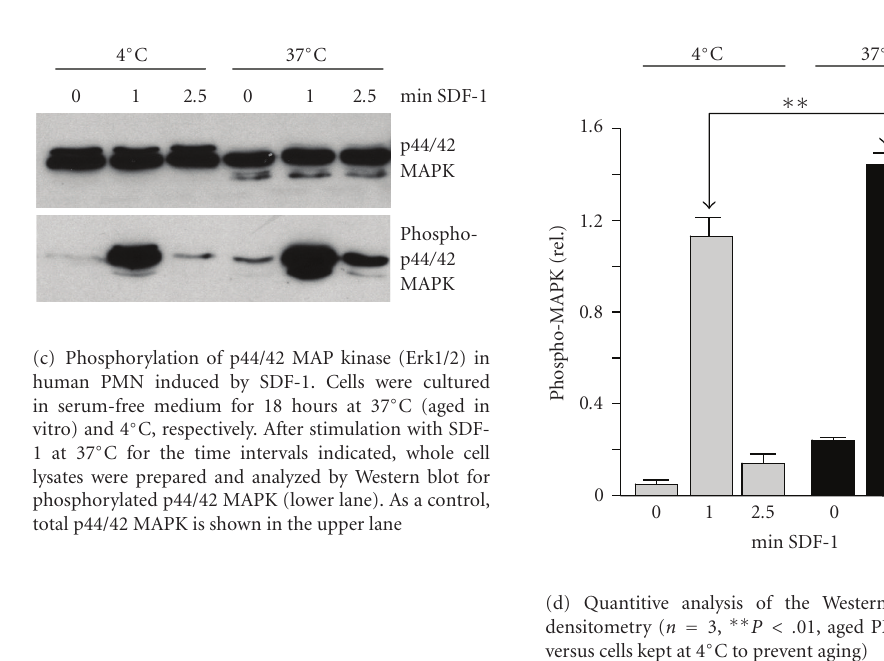
Figure 2: E ff ects of SDF-1 and IL-8 on transendothelial migration and p44/42 MAP kinase phosphorylation in human PMN in